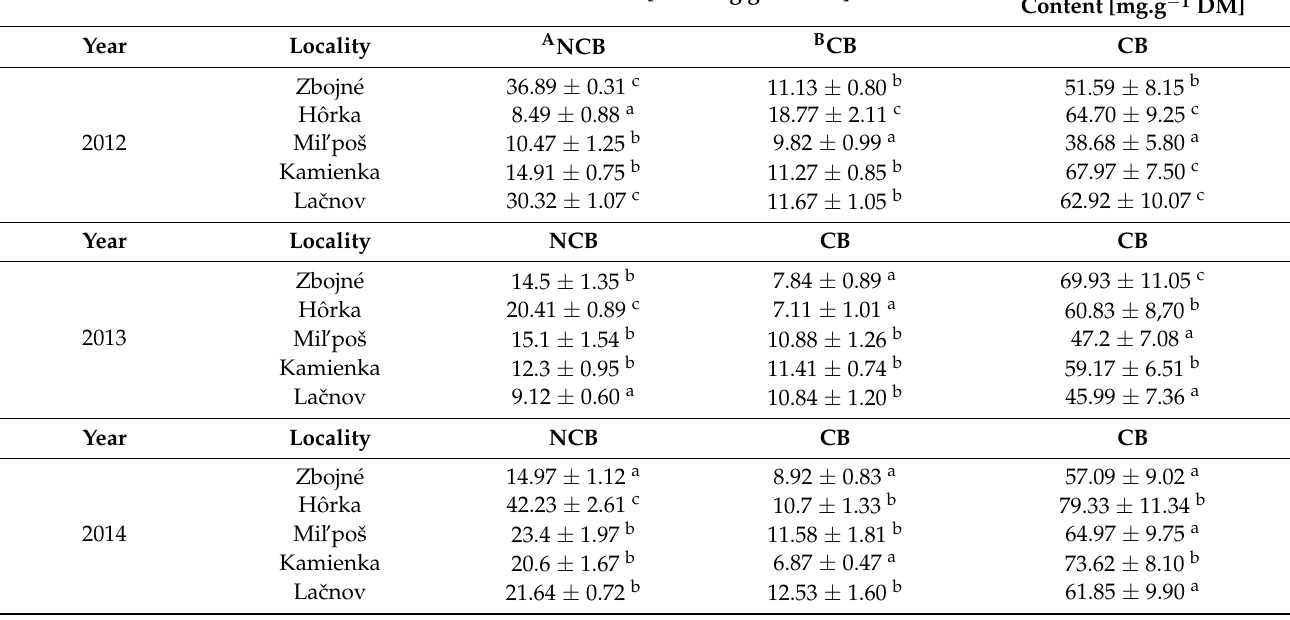
Table 1. The content of phenols evaluated in NCBs and CBs and terpene hydrocarbons in CBs within three